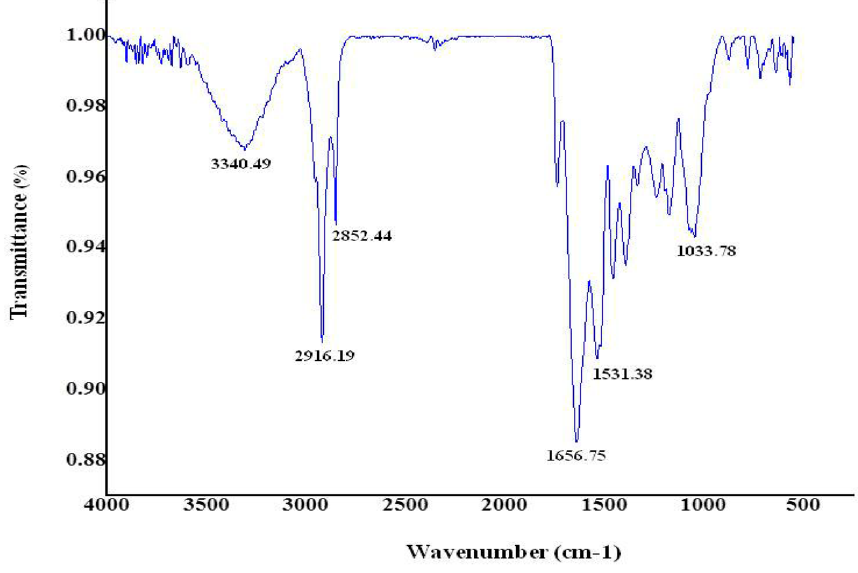
Figure 6. Fourier transform infrared (FTIR) spectrum of AgNPs fabricated sardine fish scale extract.